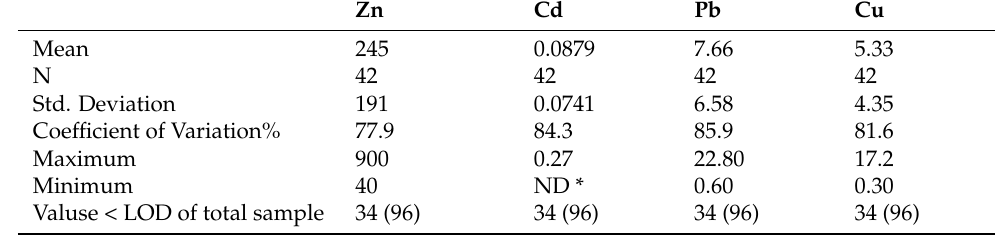
Table 3. Summary statistics of heavy metal concentrations ( µ g/g).